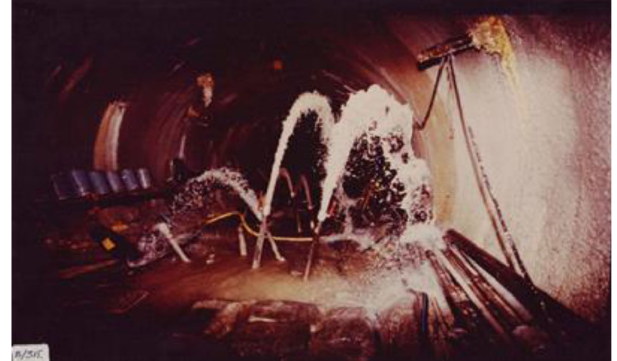
FIG. 23. Photo of water input to LEP